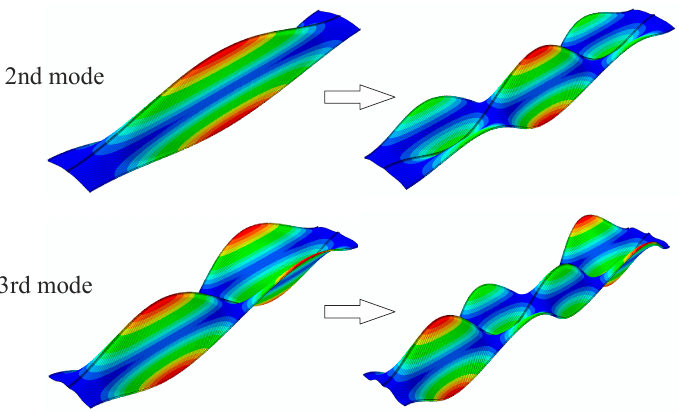
Figure 6. Changes of second and third vibration modes during loading course.